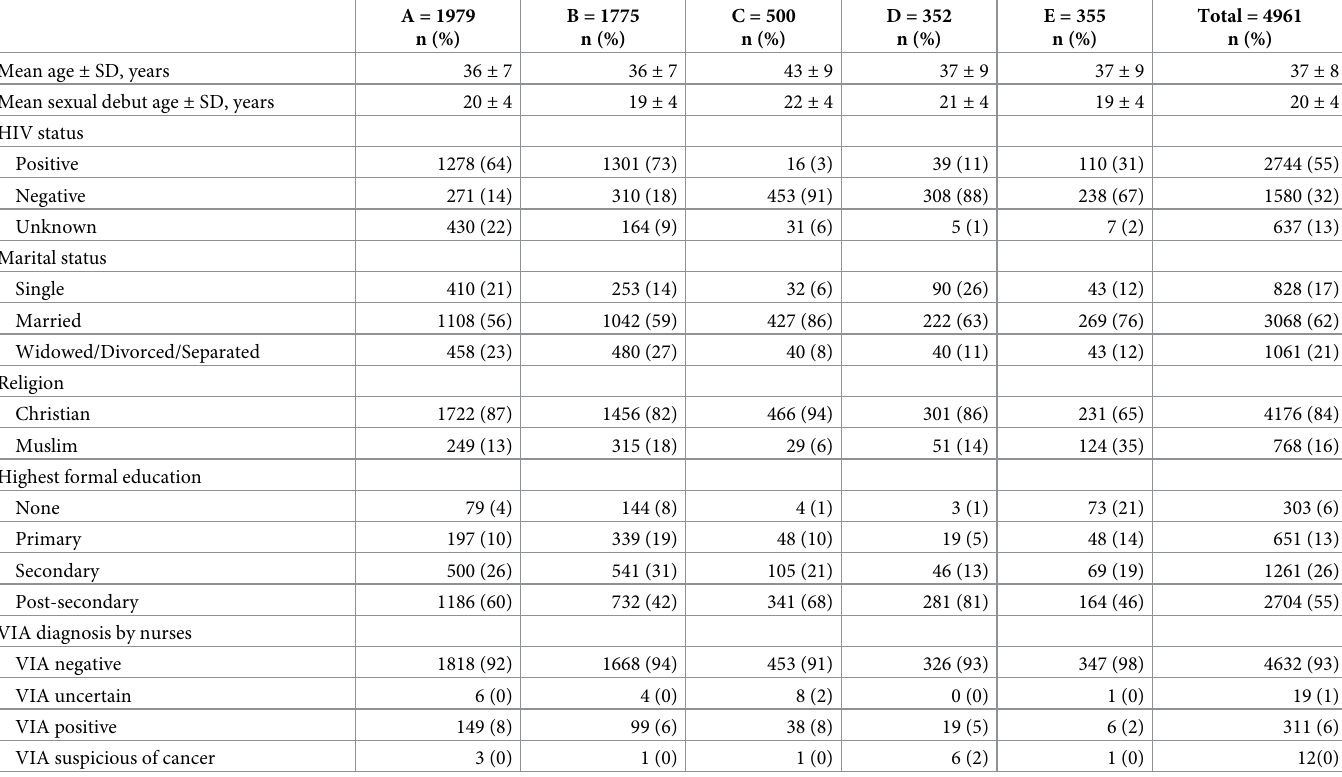
Table 2. Baseline characteristics of participants in the VIA screening program (2010–2014).